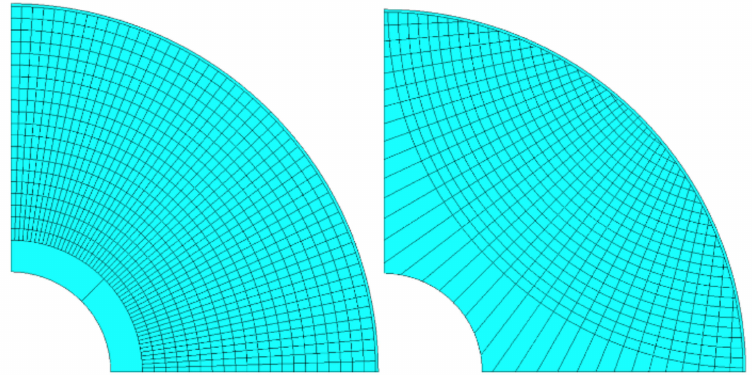
Figure 3. Forward mesh grid ( left ) and reverse mesh grid ( right